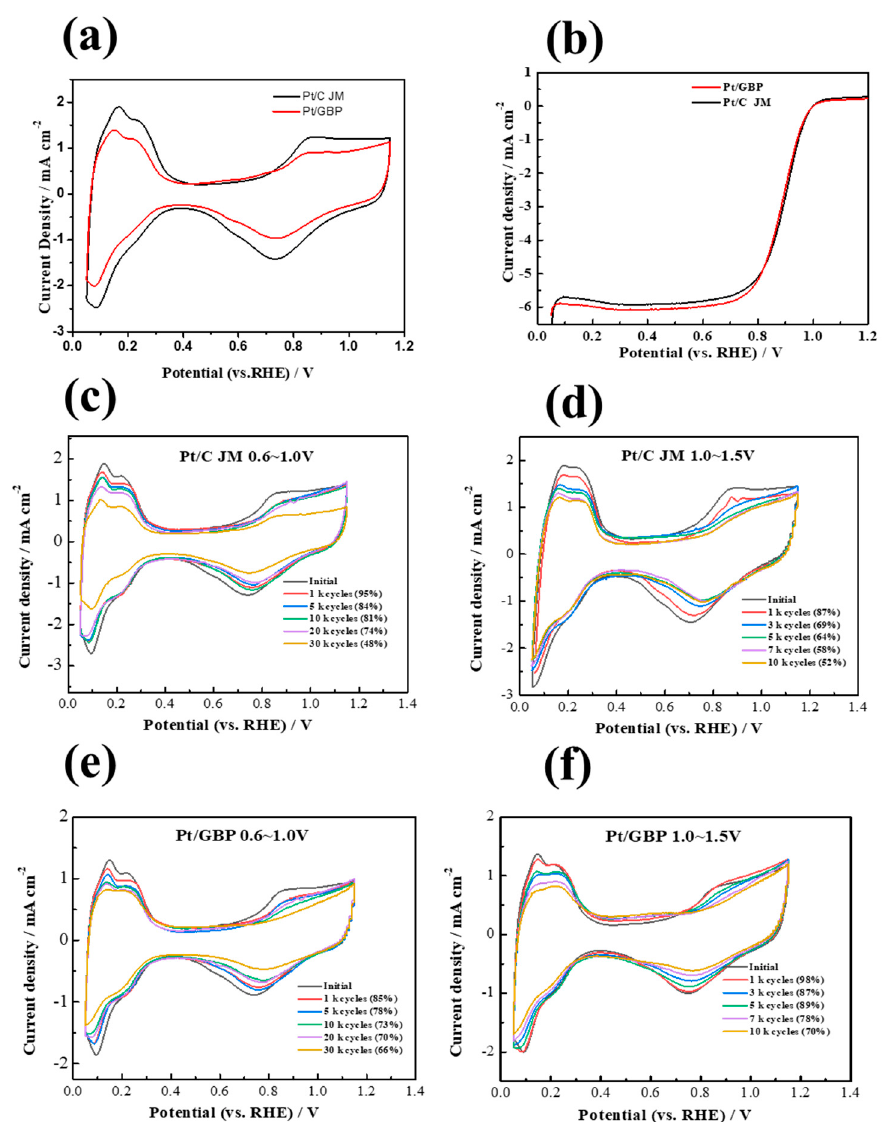
Figure 4. ( a , b ) Initial CV, LSV curves of Pt/GBP, Pt/C catalyst; ( c , d ) CV curves of Pt/C during 30 k cycles (0.6–1.0 V) and 10 k cycles of ADT (1.0–1.5 V). ( e , f ) CV curves of Pt/GBP during 30 k cycles (0.6–1.0 V) and 10 k cycles of ADT (1.0–1.5 V).